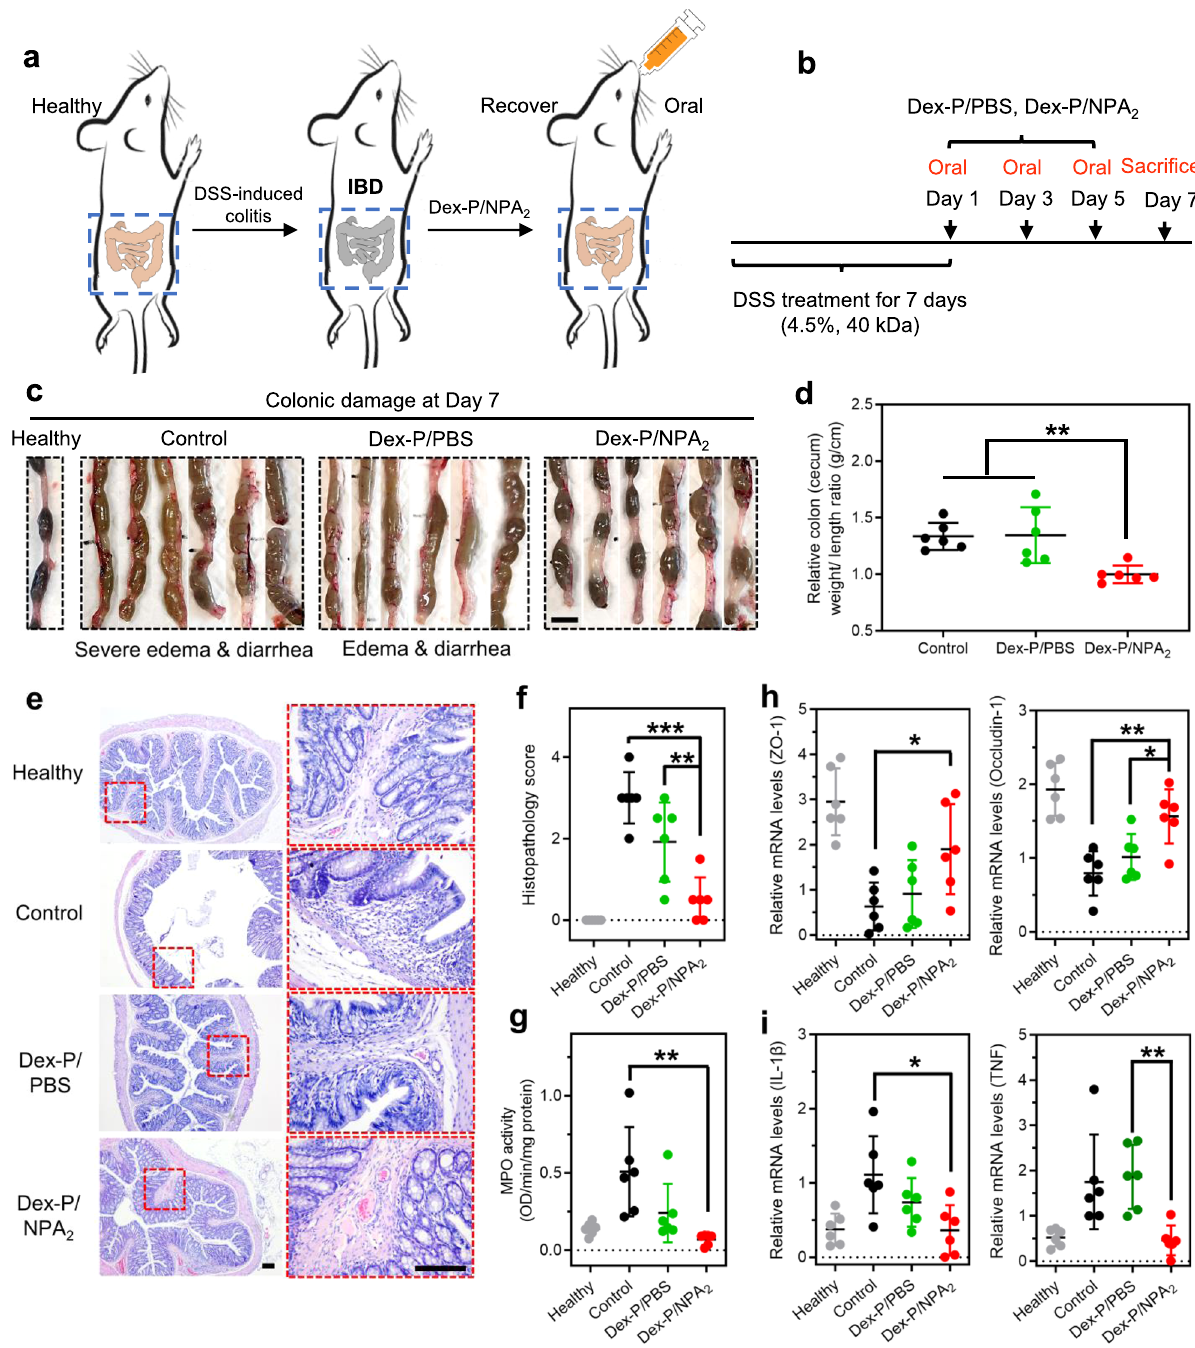
Fig. 4 Dex-P-laden NPA 2 coacervate demonstrates enhanced therapeutic ef fi cacy in a rat model of DSS-induced colitis. a , b SD rats were given 4.5% DSS in drinking water to induce acute colitis. The colitic rats received oral gavages of Dex-P-laden NPA 2 coacervates (Dex-P/NPA 2 ) or the equivalent amount of Dex-P in PBS (Dex-P/PBS) on days 1, 3, and 5. Untreated colitic SD rats were used as the negative control (Control). All SD rats were sacri fi ced on day 7. c , d Colonic edema and diarrhea caused by DSS-induced colitis in SD rats receiving Dex-P/NPA 2 were signi fi cantly relieved compared with that of the untreated colitic SD rats (Control) and colitic SD rats receiving Dex-P in PBS (Dex-P/PBS). n = 6 biologically independent rats per group. Scale bar: 10 mm. e Representative images of H&E staining demonstrated that histological in fl ammation was diminished in the colitic SD rats receiving Dex-P/NPA 2 , while histological damages were observed in untreated colitic SD rats (Control) or colitic SD rats receiving Dex-P/PBS. Scale bar: 150 μ m. f – i On day 7, colon tissues were analyzed for histopathology score f , MPO activity g , mRNA levels of tight junction-associated proteins including ZO-1 and occludin-1 h , and pro-in fl ammatory cytokines including interleukin IL - 1 β and TNF i . Data were presented as mean ± SD. n = 6 biologically independent rats per group. * p < 0.05, ** p < 0.01, *** p < 0.001 (Ordinary one-way ANOVA). Source data are provided as a Source Data fi le for Fig. 4d, f –